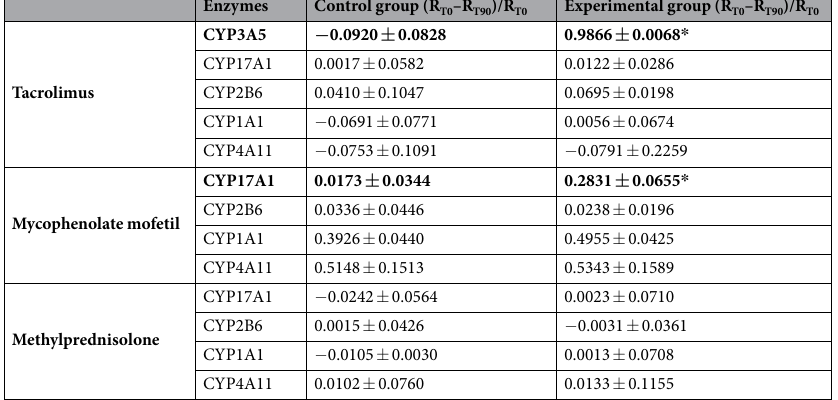
Table 3. The enzyme assay results. R T0 : the relative peak area of substrate before reaction; R T90 : the relative peak area of substrate at 90 min after reaction. * p < 0.05 compared to the control group. Data are analyzed from three independent